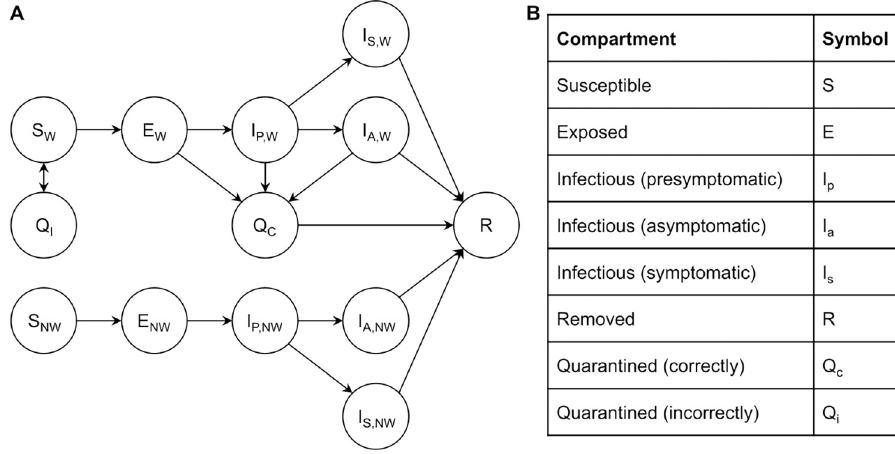
Fig 1. Compartmental model structure. Subscript “W” denotes a wearable user and “NW” denotes otherwise. Two core model equations are presented below; remaining parameters, equations, and assumptions are outlined in Section 1 in S1